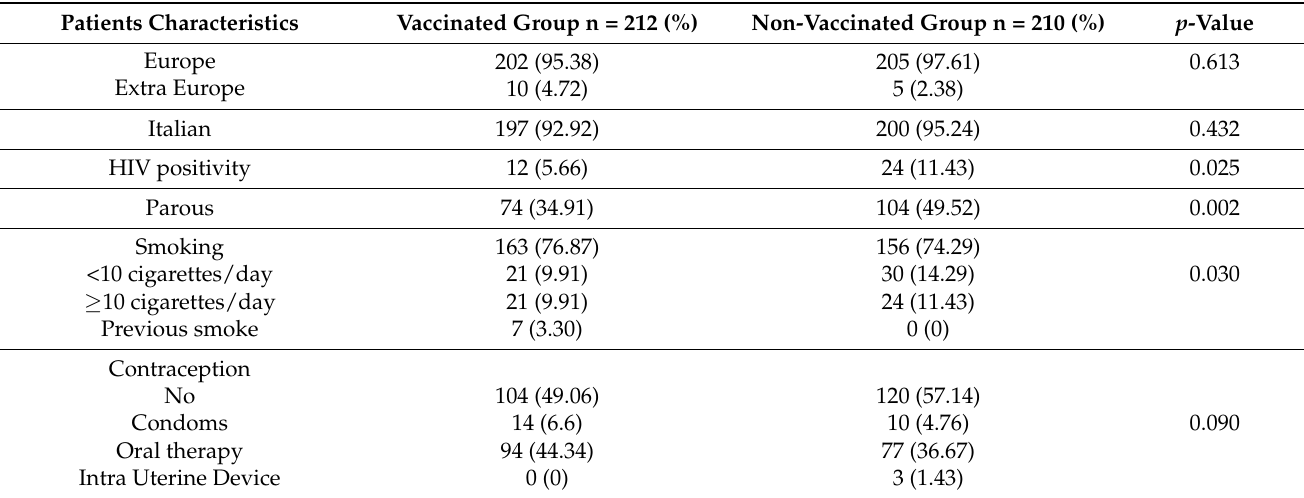
Table 1. Demographic characteristics of people enrolled in the study.